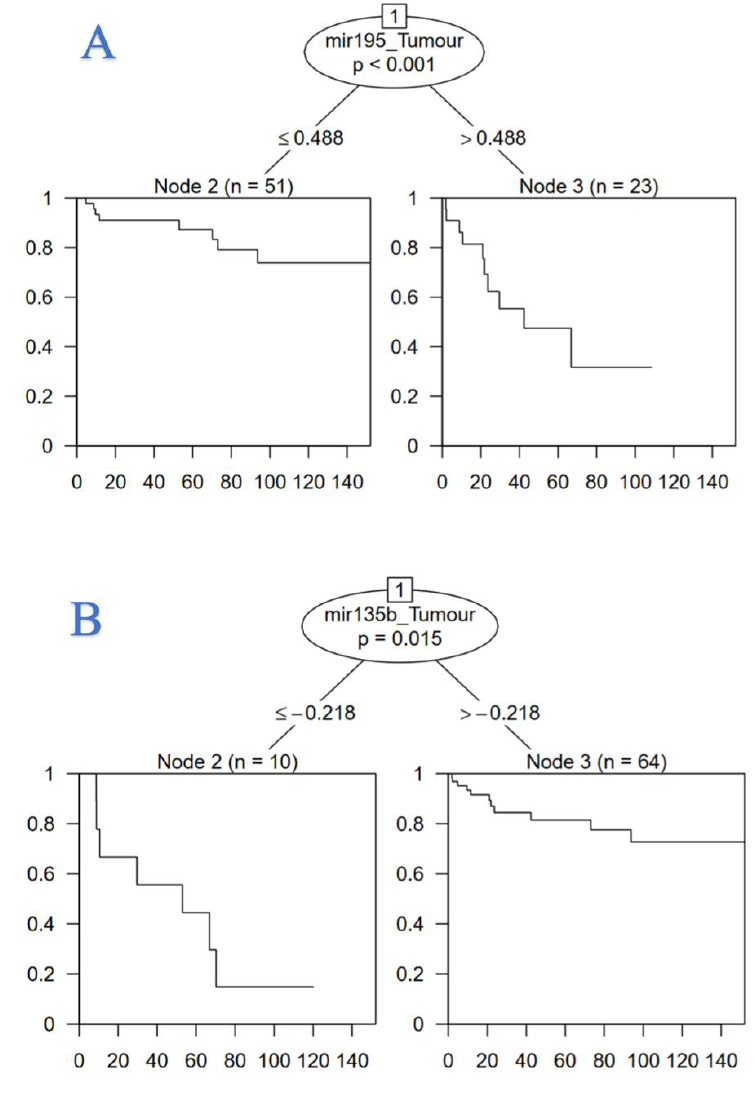
Figure 2. Regression tree illustrating the clinical utility of ( A ) miR-195 and ( B ) miR-135b measurement to predict time to recurrence in analysis of 74 patients treated with curative intent for colorectal carcinoma.